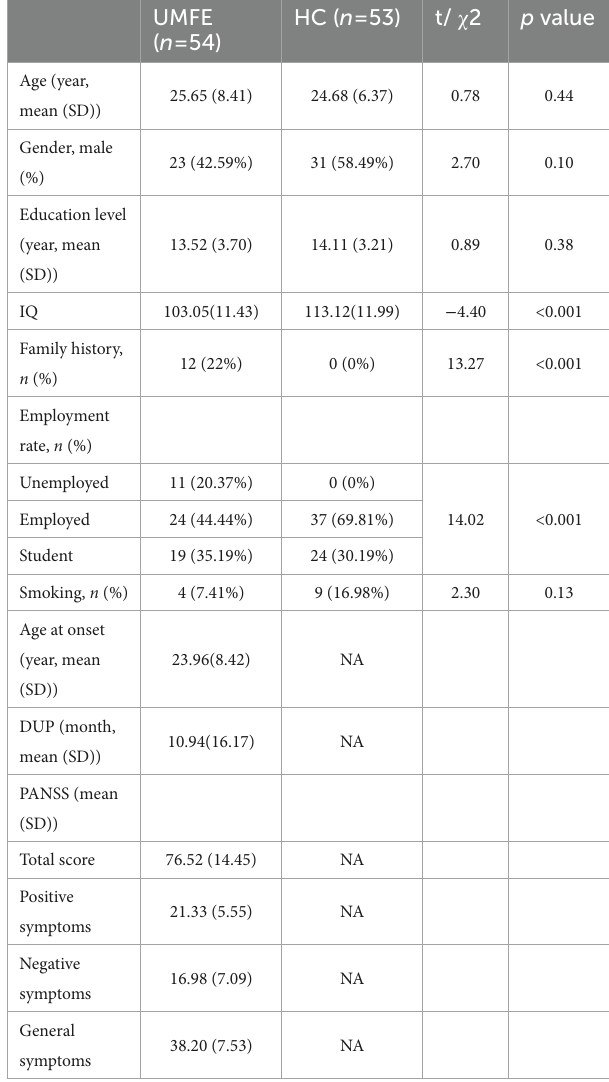
TABLE 1 Social-demographical and clinical characteristics of all the study